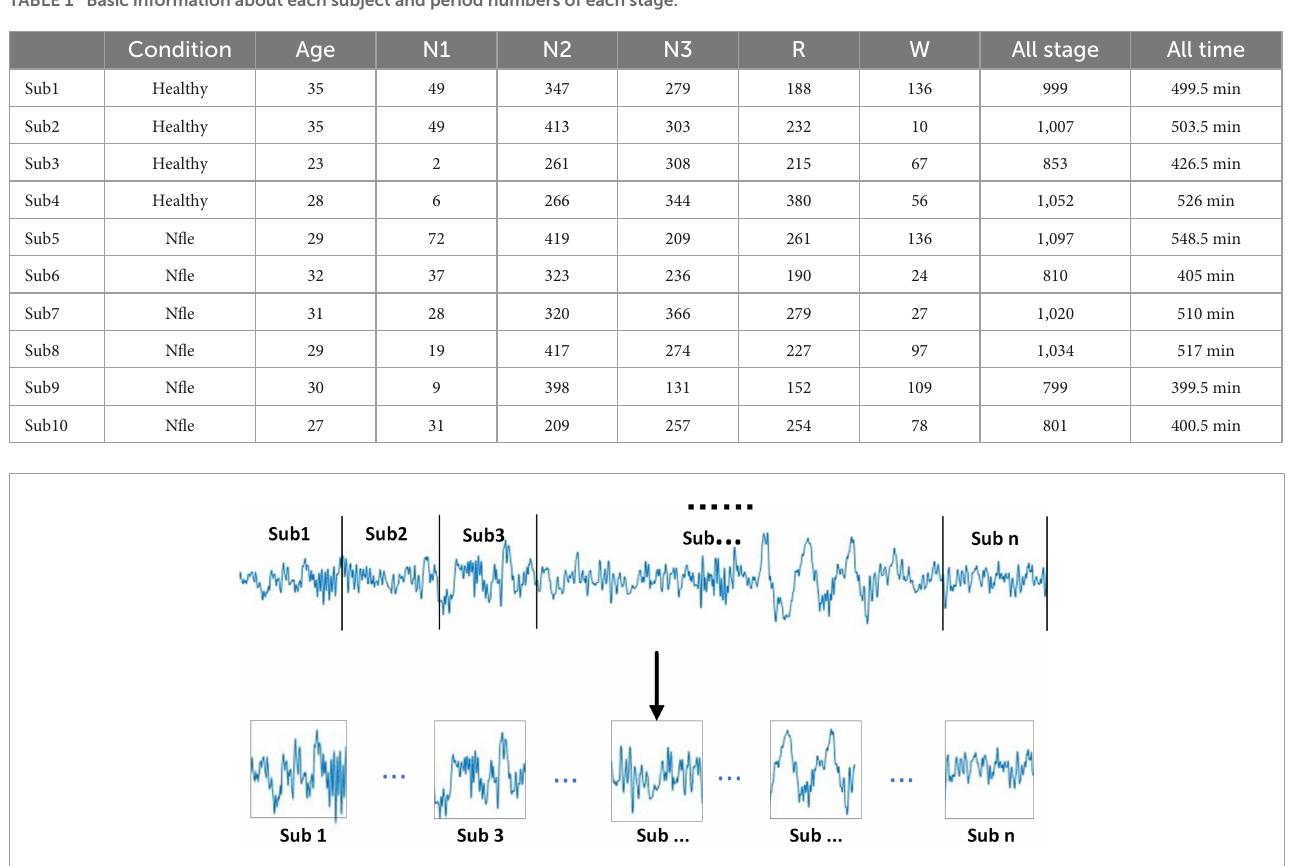
FIGURE2 Sub-period division method direct PLV feature fusion decision